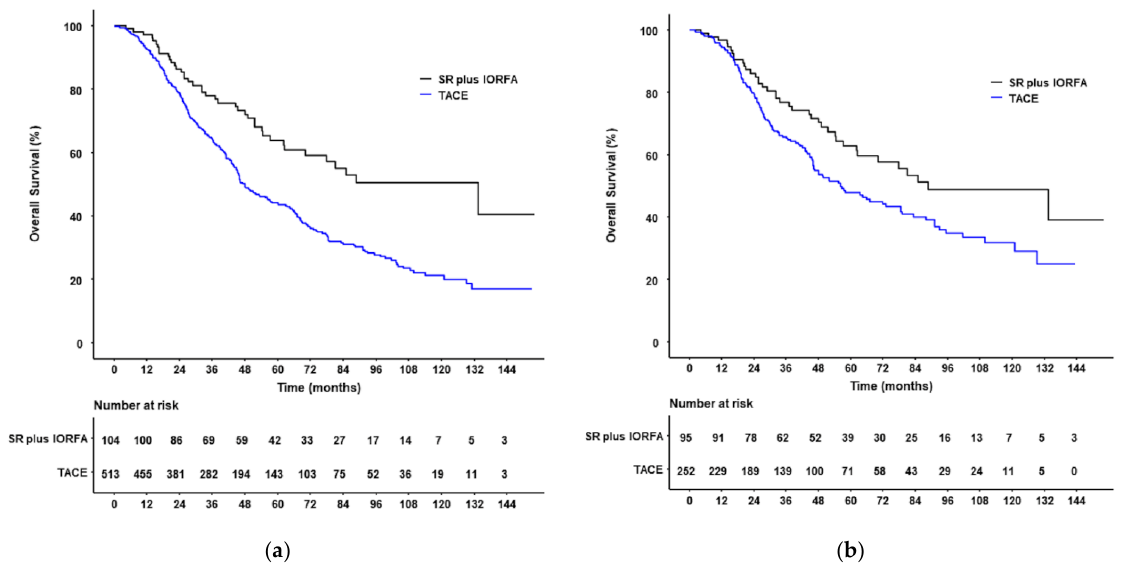
Figure 2. Kaplan–Meier analyses of overall survival (OS) in patients who underwent SR plus IORFA